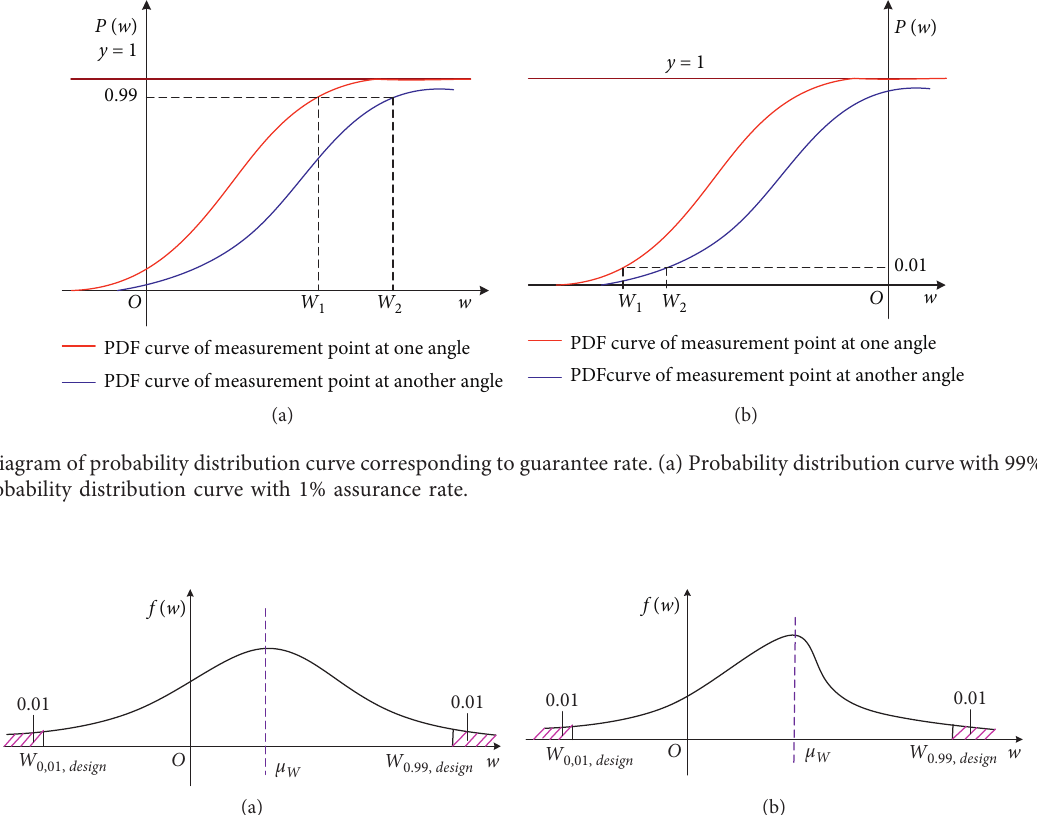
and W . (a)Gaussian distribution case; (b) non- 0 . 99 , design 0 . 01 , design